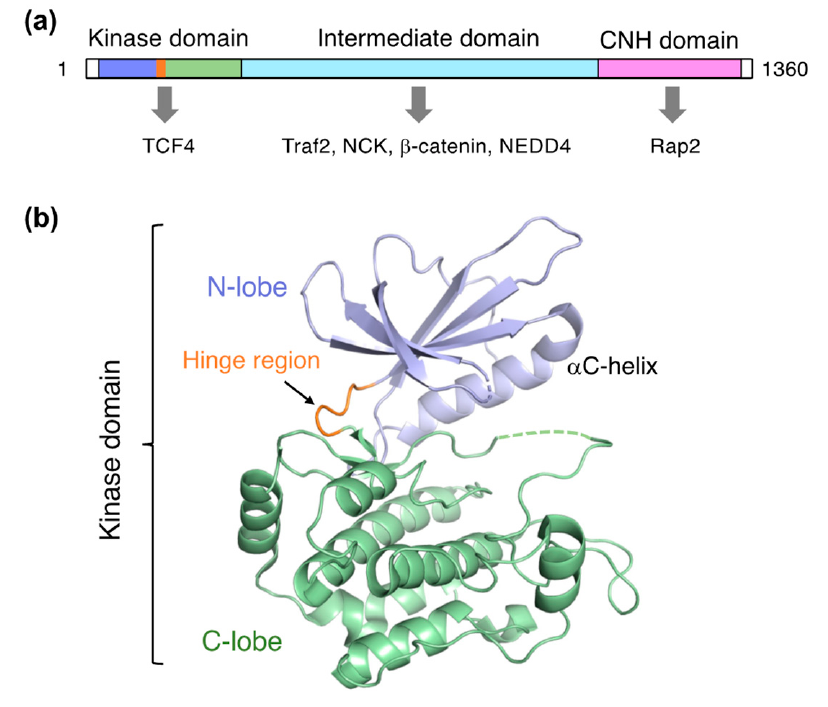
Figure 1. Structure of TNIK. ( a ) Domain organization of TNIK and its interacting proteins (indicated by arrows). ( b ) Crystal structure of the apo-form TNIK kinase domain (PDB ID: 5CWZ) [12].